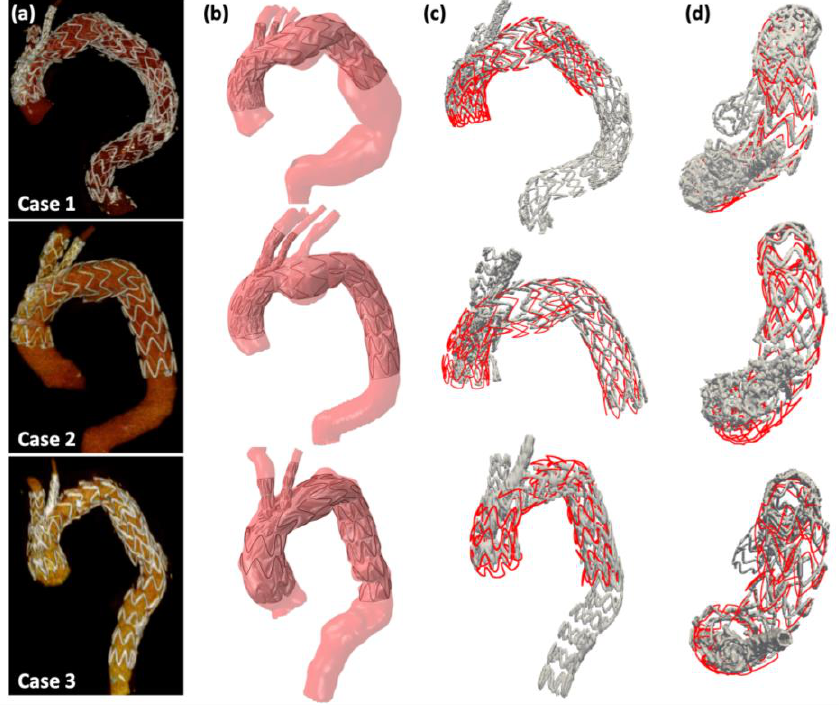
Figure 3. ( a ) 3-dimensional reconstructions of post-operative CT scans for the three cases. ( b ) Simulation results. ( c ) Sagittal views of the qualitative comparison between stent-rings extracted from simulations (in red) and post-operative CT scan (in grey). ( d ) Transversal views.